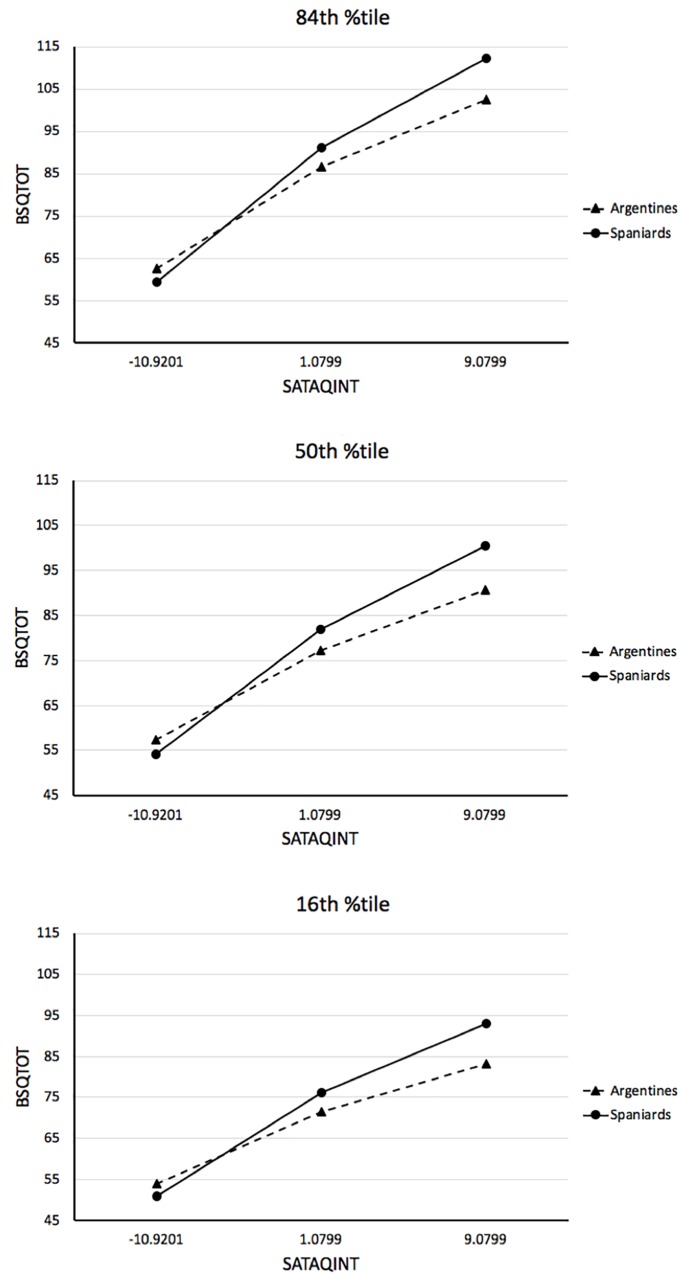
Visual representation of the association between internalization (SATAQ-AI centered scores) and Body Dissatisfaction (BSQ scores) in the Spanish vis-à-vis the Argentine sample at each of the probed BMI values.